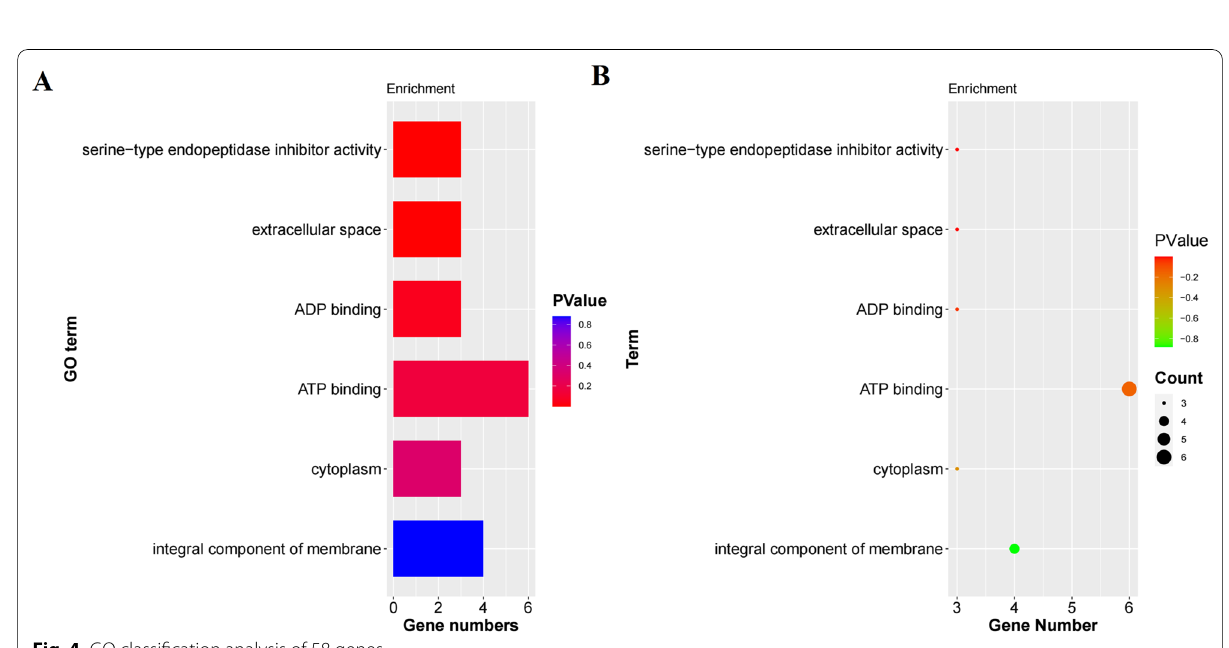
file 6: Table S5). Two comparative groups (H71 vs. L71 and H284 vs. L284) were set up for the two rice cultivar under different treatments. The letter H, letter L, number